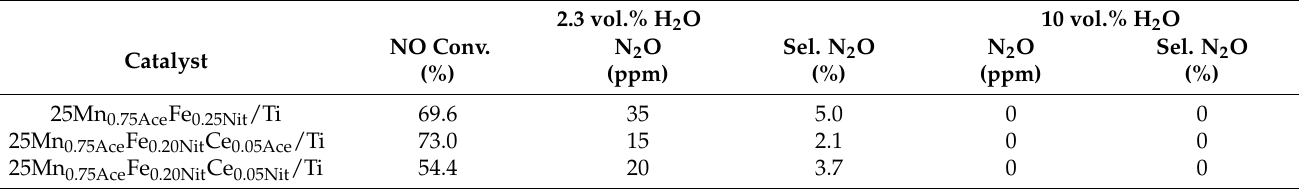
Table 1. N 2 O formation data at 150 ◦ C. 2.3 vol.% H 2 O 10 vol.% H 2